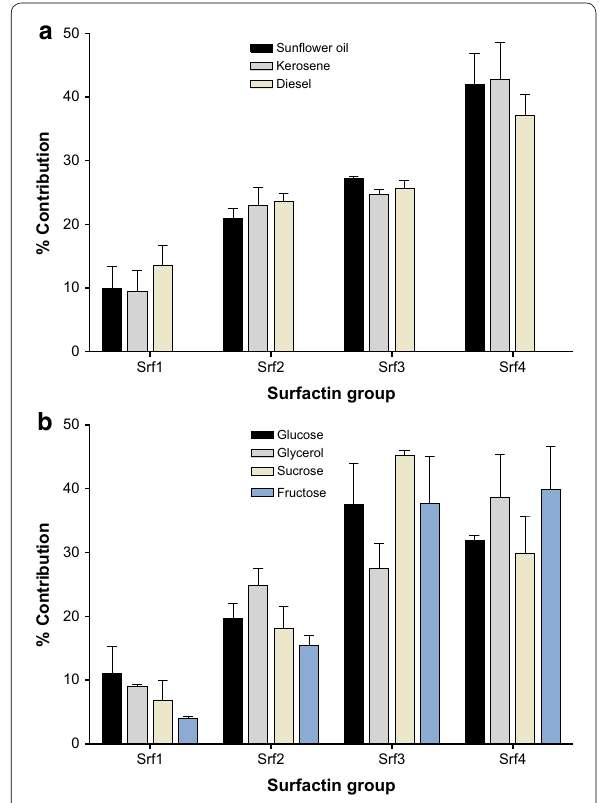
Fig. 2 Comparison of the extracts obtained from ST34 cultivated in mineral salt medium supplemented with a water immiscible substrates and b water miscible substrates, showing the relative con- tribution of each of the surfactin groups in the biosurfactant extracts. The contribution was calculated from UPLC profiles, with the assump- tion that all the surfactin species have similar ion responses. Each bar represents the average of three culture extracts with standard error of the mean